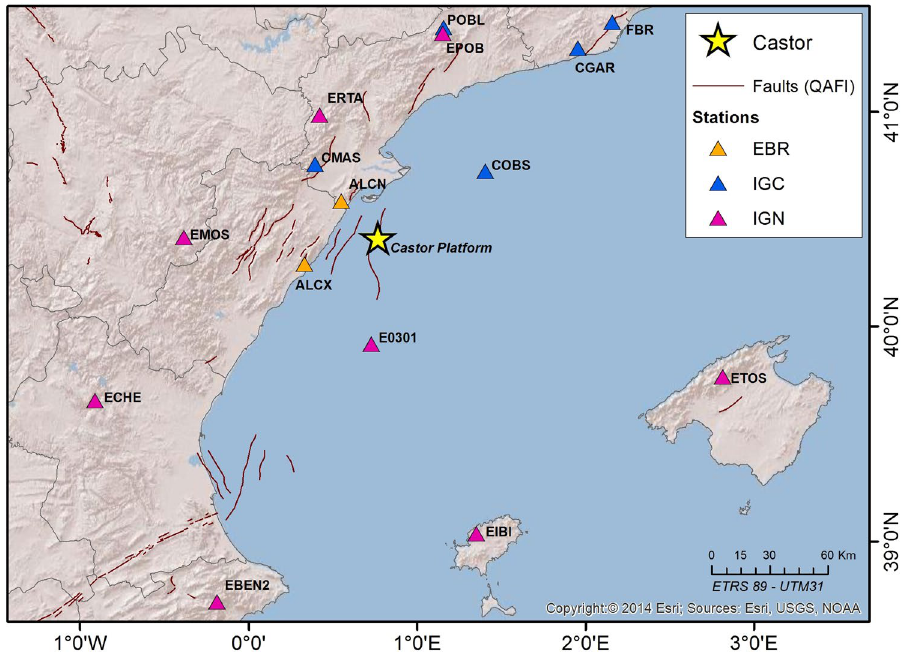
Figure 4. Seismic stations close to Castor platform, which recorded events of the seismic sequence after the injection. The stations are managed by different institutions: Ebro Observatory stations (EBR) in orange, Catalonian Geological Institute (IGC) stations in blue and Spanish National Network (IGN) in pink. The figure was generated by using the ESRI software, ArcGIS for desktop, version 10.1.